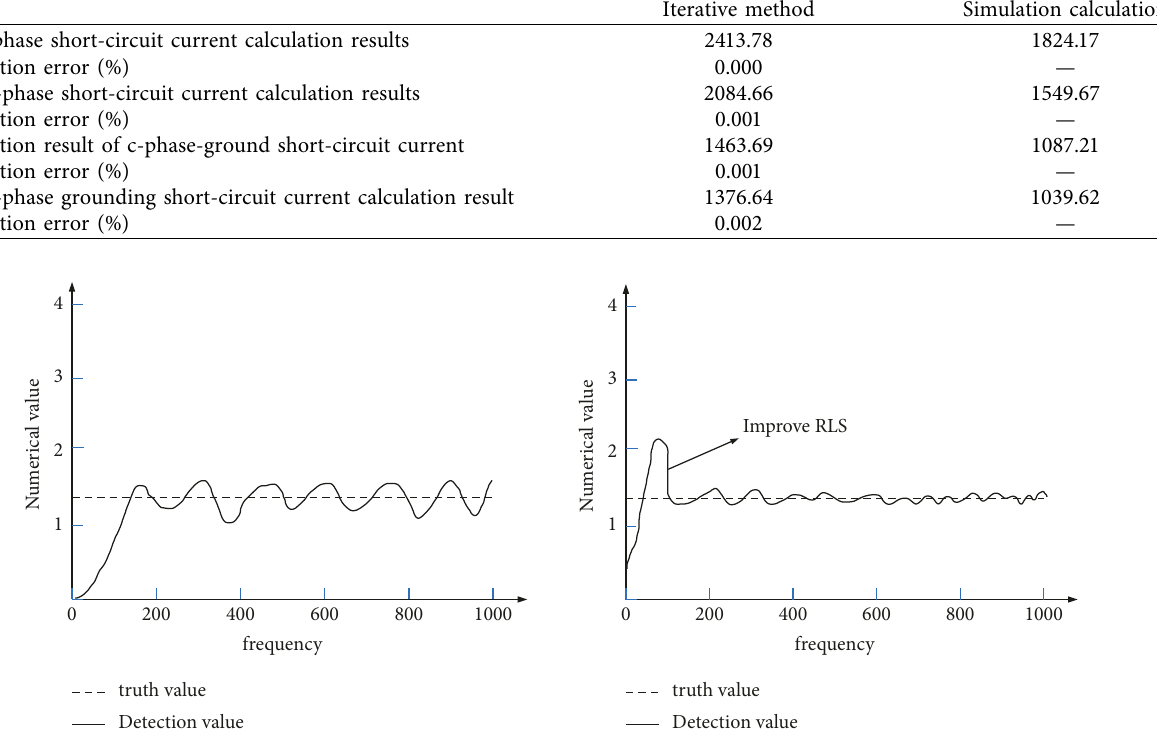
Figure 7: Waveforms of the convergence of the weights of the two